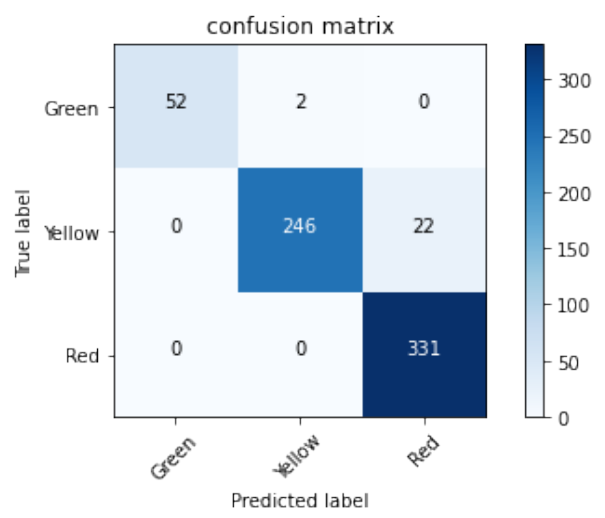
Figure 11. ANN confusion matrix on San Lorenzo test case.